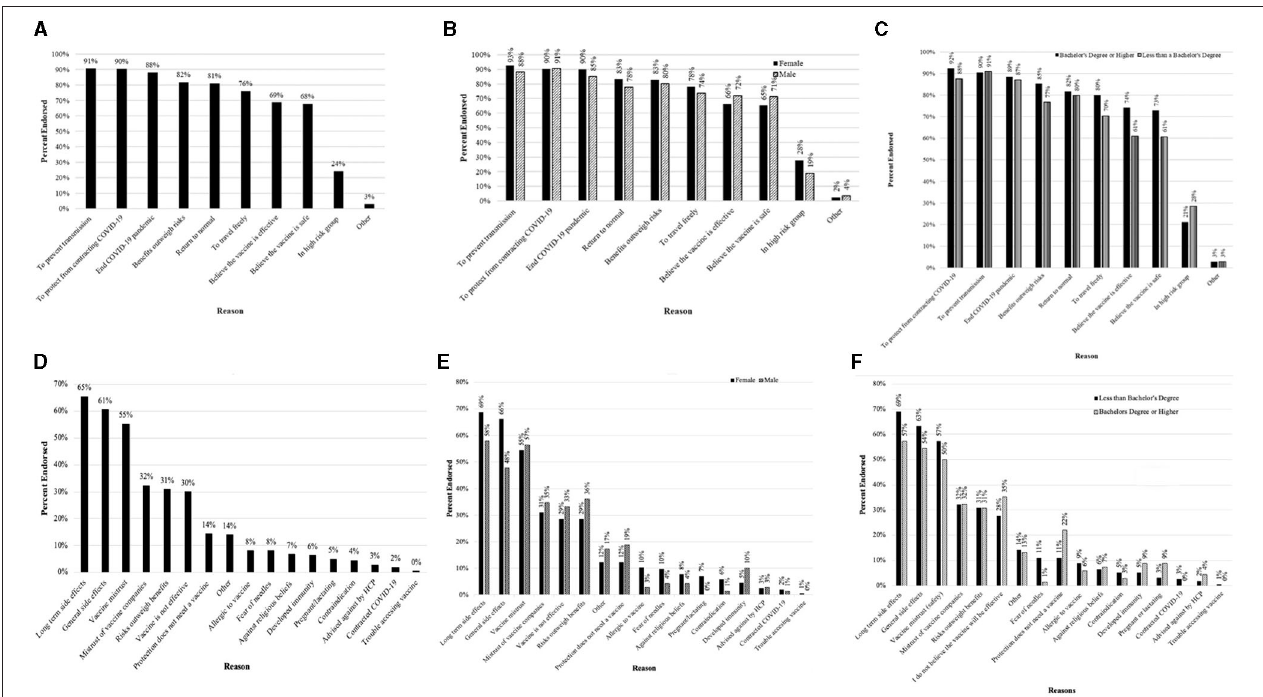
FIGURE 1 | Reasons for receiving the COVID-19 vaccine reported by participants that indicated vaccine willingness (A–C) and Reasons for not wanting to receive the COVID-19 vaccine reported by participants that indicated vaccine unwillingness (D–F) . (A) Overall reasons for receiving the COVID-19 vaccine. (B) Reasons for receiving the COVID-19 vaccine reported between male and female participants. (C) Reasons for receiving the COVID-19 vaccine reported between participants with less than a Bachelor’s degree or a Bachelor’s degree or higher. (D) Overall reasons for not wanting to receive the COVID-19 vaccine. (E) Reasons for not wanting to receive the COVID-19 vaccine across sex. (F) Reasons for not wanting to receive the COVID-19 vaccine reported between participants less than a Bachelor’s degree or a Bachelor’s degree or